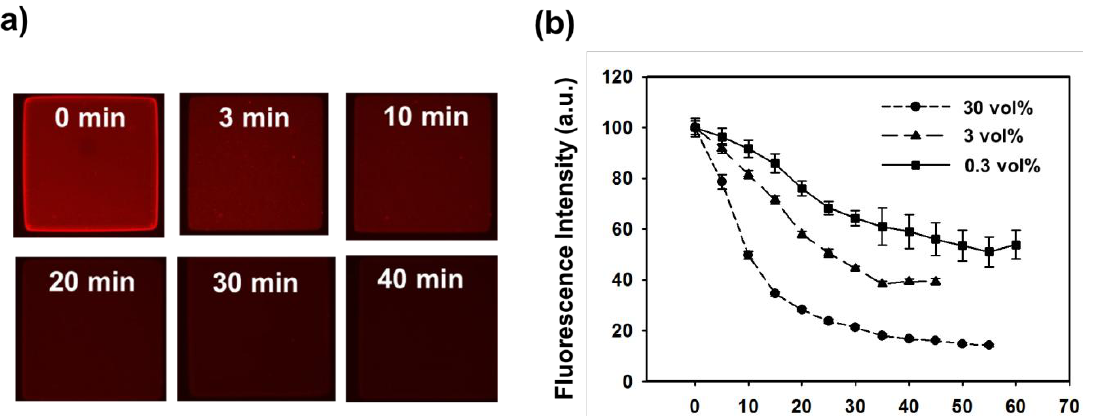
O -PSt/PTh immobilized hydrogel 3 4